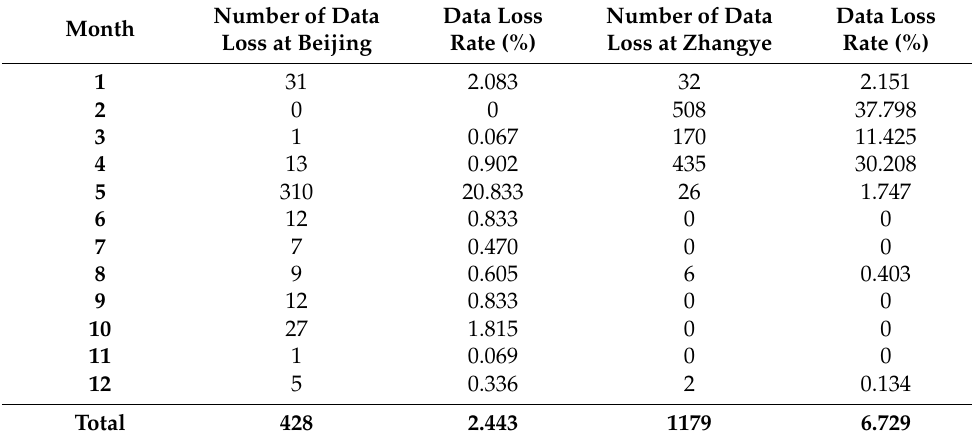
Table 1. The distribution of data at Beijing and